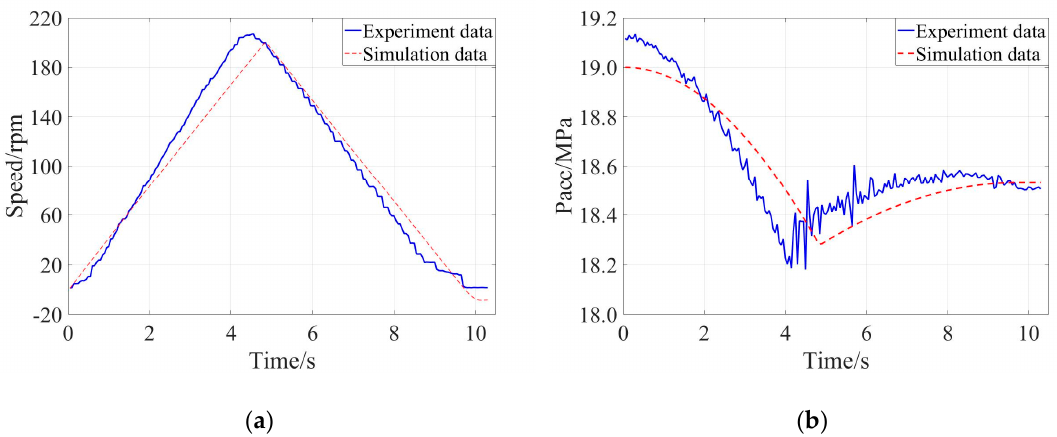
Figure 16. Comparison of the experimental result and simulation result when the initial braking speed was 150 rpm: ( a ) Evolution of speed of flywheel, ( b ) Evolution of pressure of accumulator.